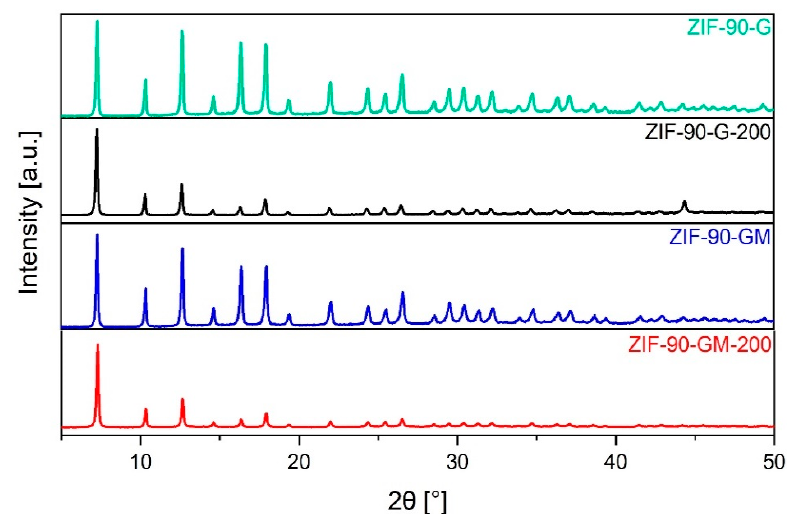
Figure 4. PXRD of ZIF-90-G and ZIF-90-GM before and after thermal burst activation at 200 °C.